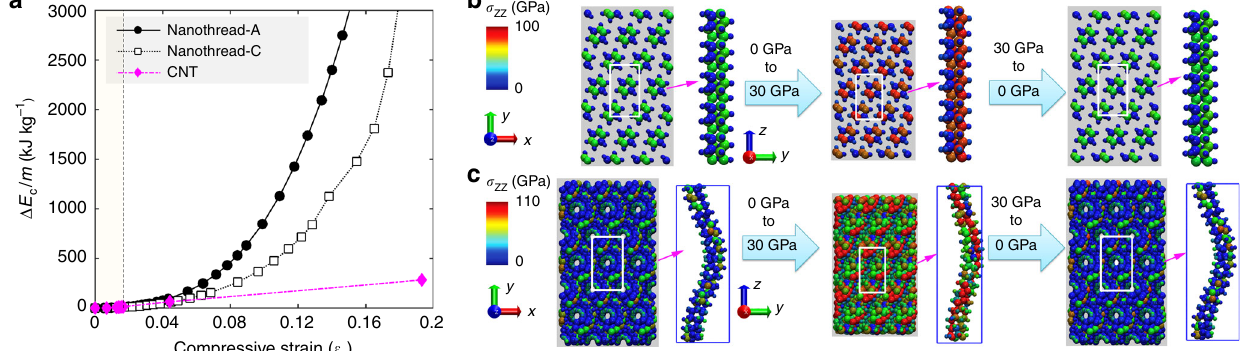
Fig. 3 Radial compression of nanothread triangular lattice from simulation. a The compressive strain energy density as a function of compressive strain for nanothread-A, nanothread-C, and CNT(10,10). b Nanothread-A lattice compressed from 0 GPa (left panel) to 30 GPa (middle panel) and relaxed to 0 GPa (right panel). c Nanothread-C lattice compressed from 0 GPa (left panel) to 30 GPa (middle panel) and relaxed to 0 GPa (right panel). Atoms in b , c are coloured according to the axial virial stress. In each panel, left images show the periodic triangular lattice (in top-view) and right images show a representative individual nanothread (in side-view) in the triangular